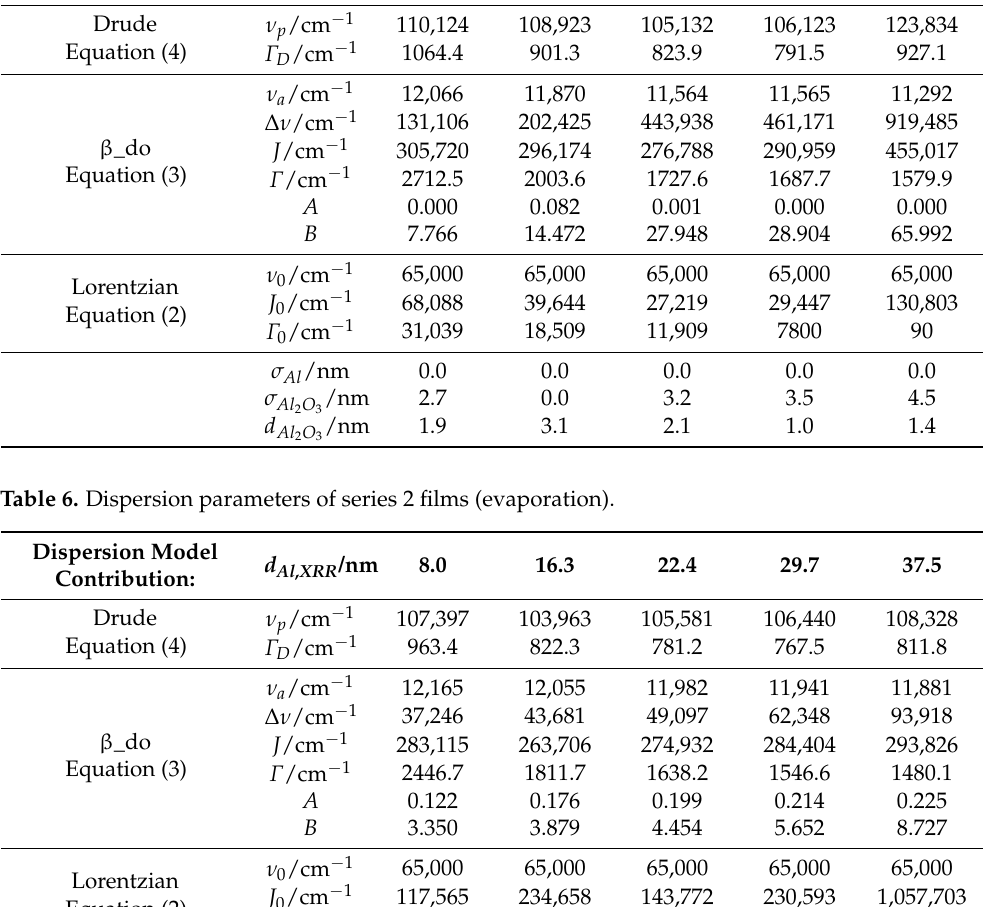
Table 5. Dispersion parameters of series 1 films (sputtering).